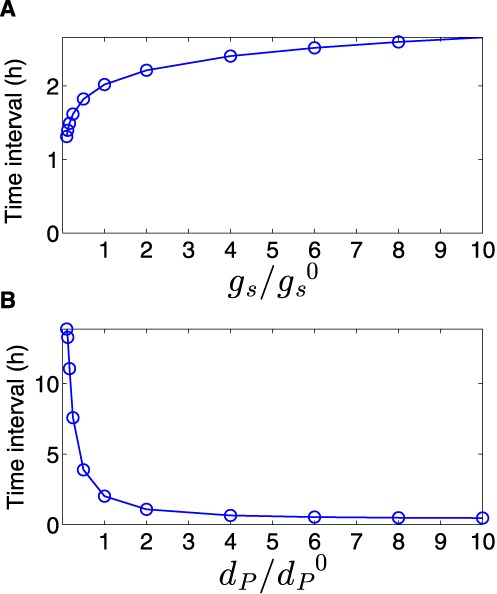
Time interval between the down-regulation of target 1 and up-regulation of target 2. The time interval in this analysis is defined as the difference between the time it takes for targets 1 and 2 to reach halfway to their new steady states upon activation of the sRNA. The time interval, obtained from simulations based on the deterministic model, increases with sRNA transcription rate (A) and decreases with TF degradation rate (B). The values of \documentclass[12pt]{minimal}
\usepackage{amsmath}
\usepackage{wasysym}
\usepackage{amsfonts}
\usepackage{amssymb}
\usepackage{amsbsy}
\usepackage{upgreek}
\usepackage{mathrsfs}
\setlength{\oddsidemargin}{-69pt}
\begin{document}
}{}$g_s^0$\end{document} and \documentclass[12pt]{minimal}
\usepackage{amsmath}
\usepackage{wasysym}
\usepackage{amsfonts}
\usepackage{amssymb}
\usepackage{amsbsy}
\usepackage{upgreek}
\usepackage{mathrsfs}
\setlength{\oddsidemargin}{-69pt}
\begin{document}
}{}$d_p^0$\end{document} are reported in Table S1.